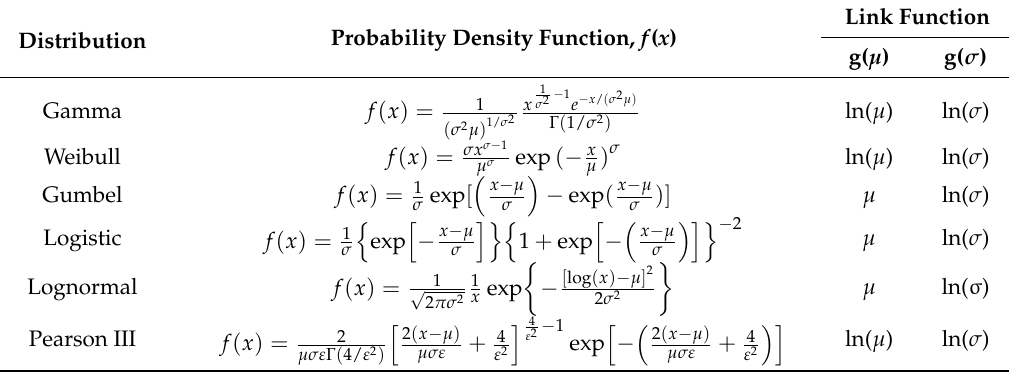
Table 1. Probability density functions of the marginal distributions and their link functions. Distribution